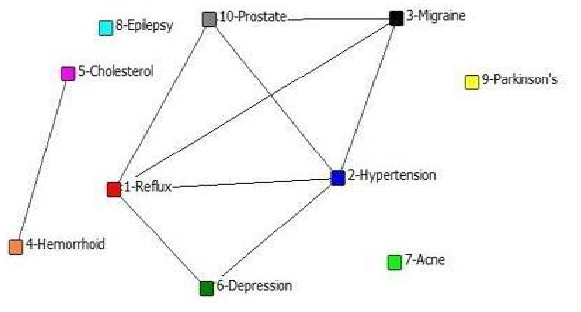
Figure. 7. Disease network